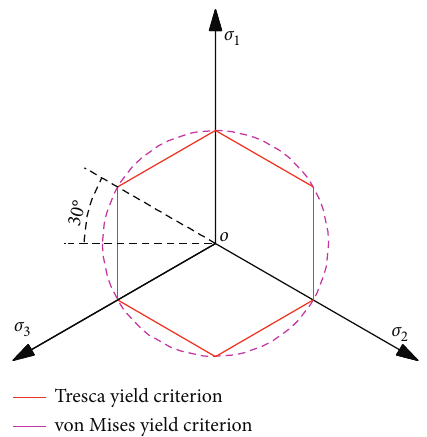
Figure 1: Tresca and von Mises criterion in the π